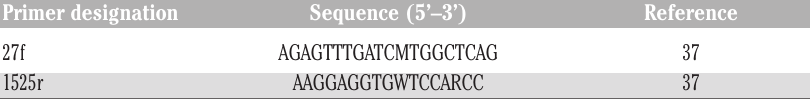
Table 1. Oligonucleotide primers used for PCR amplification of 16S rDNA.